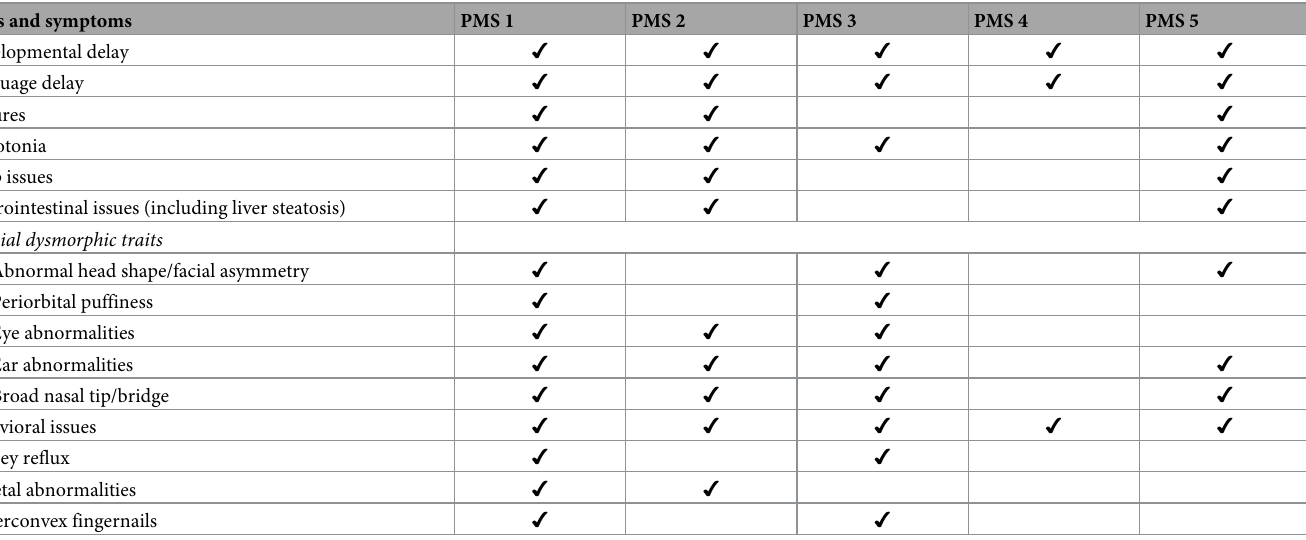
Table 3. Summary of clinical features for each individual with